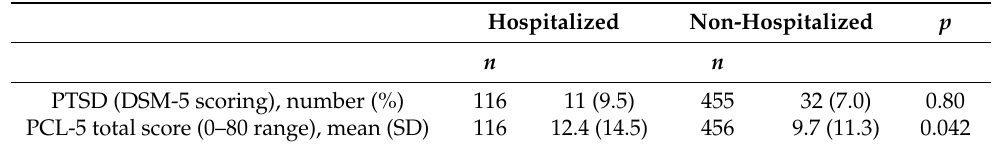
Table 2. Symptoms of post-traumatic stress (PCL-5) ( n = 572).